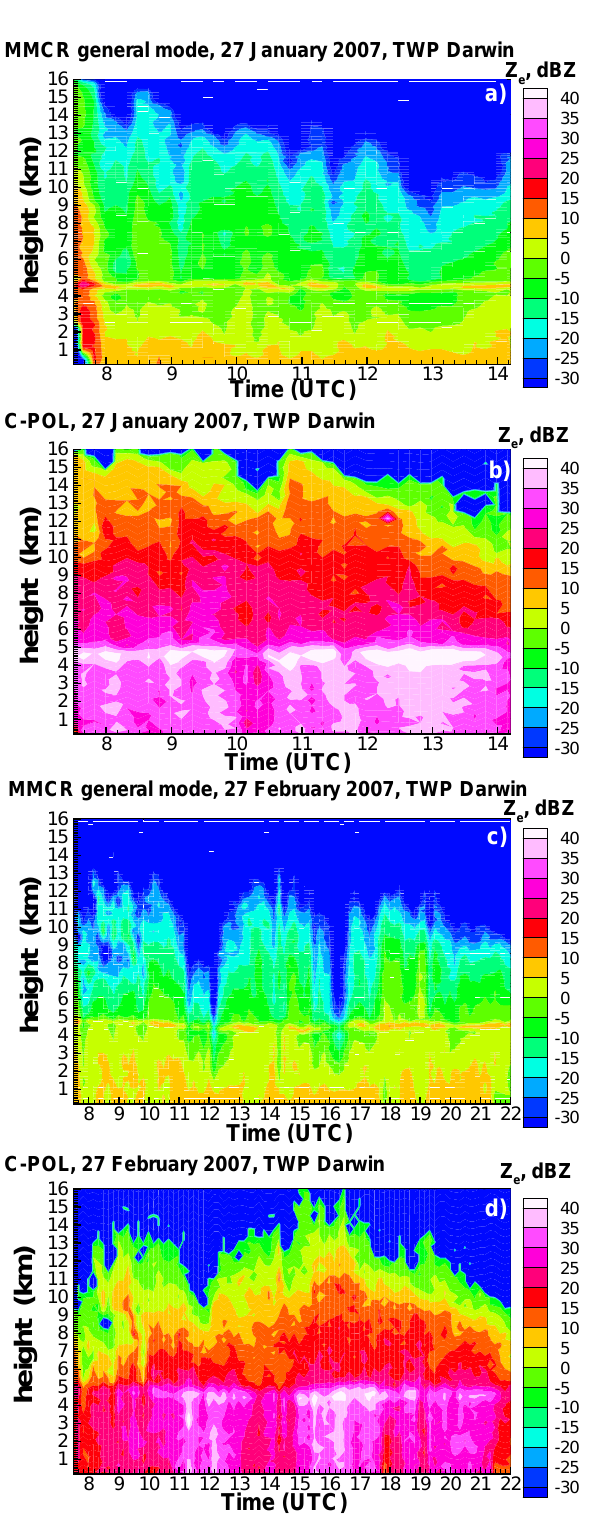
Fig. 1. TWP Darwin MMCR ( a and c ) and C-POL ( b and d ) reflec- tivity cross sections observed in stratiform precipitation events on 27 January 2007 (a and b) and 27 February 2007 (c and d).